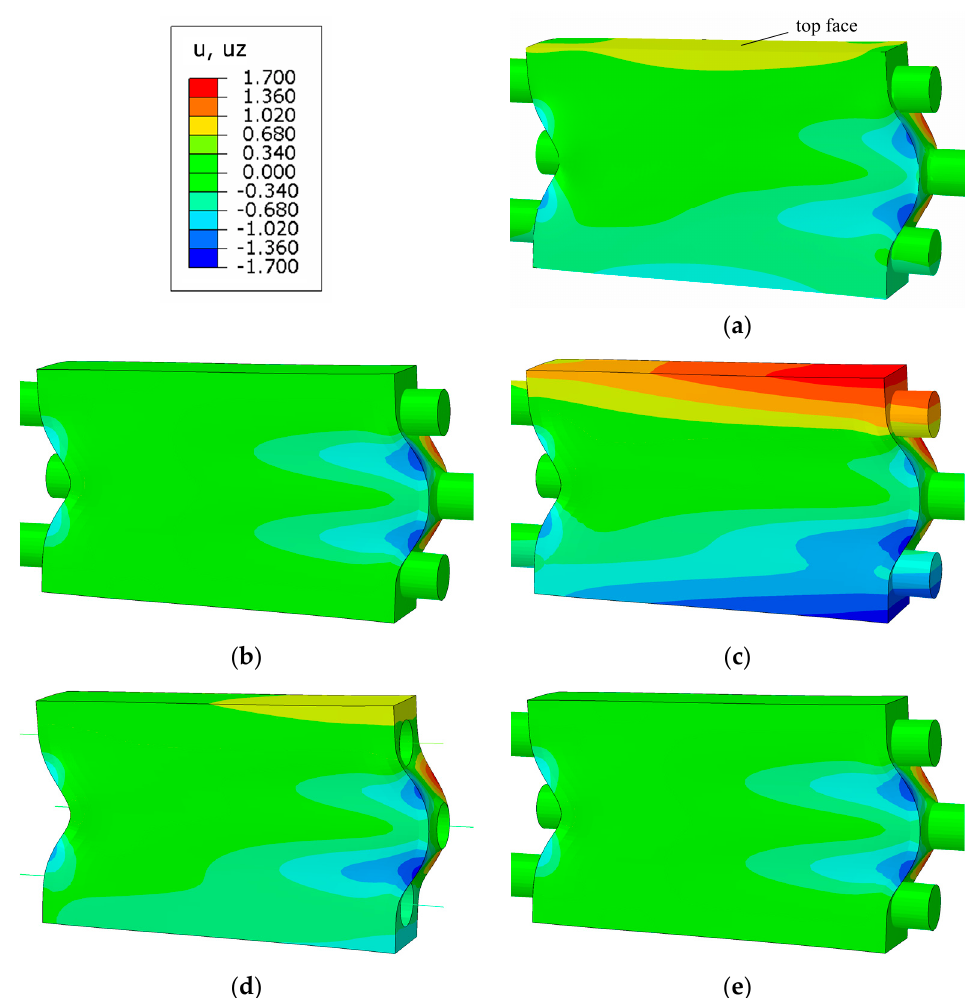
Figure 11. Contour plots of the out-of-plane displacements u z in mm for ( a ) the full-geometry model and the four efficient cable-modeling approaches ( b ) solid, anisotropic, ( c ) solid, HGO, ( d ) beam, anisotropic, and ( e ) solid/beam, cubic (fit to S ij ) of the three-cable szs-type specimen with free end rotation.